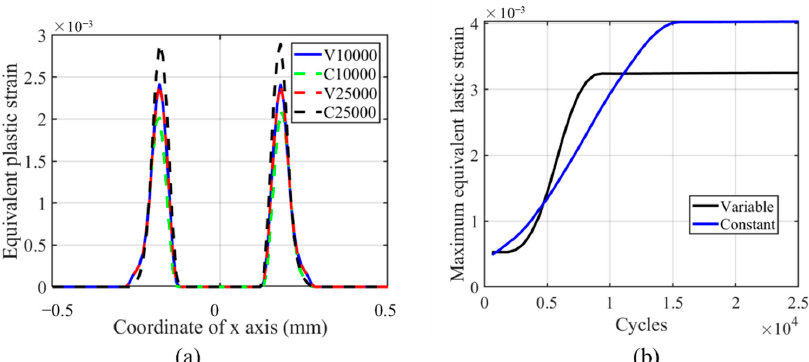
Figure 26. Profile and history of the equivalent plastic strain for the cylindrical pad in partial slip regime for both CWCM and VWCM when δ = 10 mm: ( a ) is the profiles in 10,000th cycle and 250,000th cycle, and ( b ) is the maximum value history. The history and profile of tangential and shear stress are shown in Figure 27. From